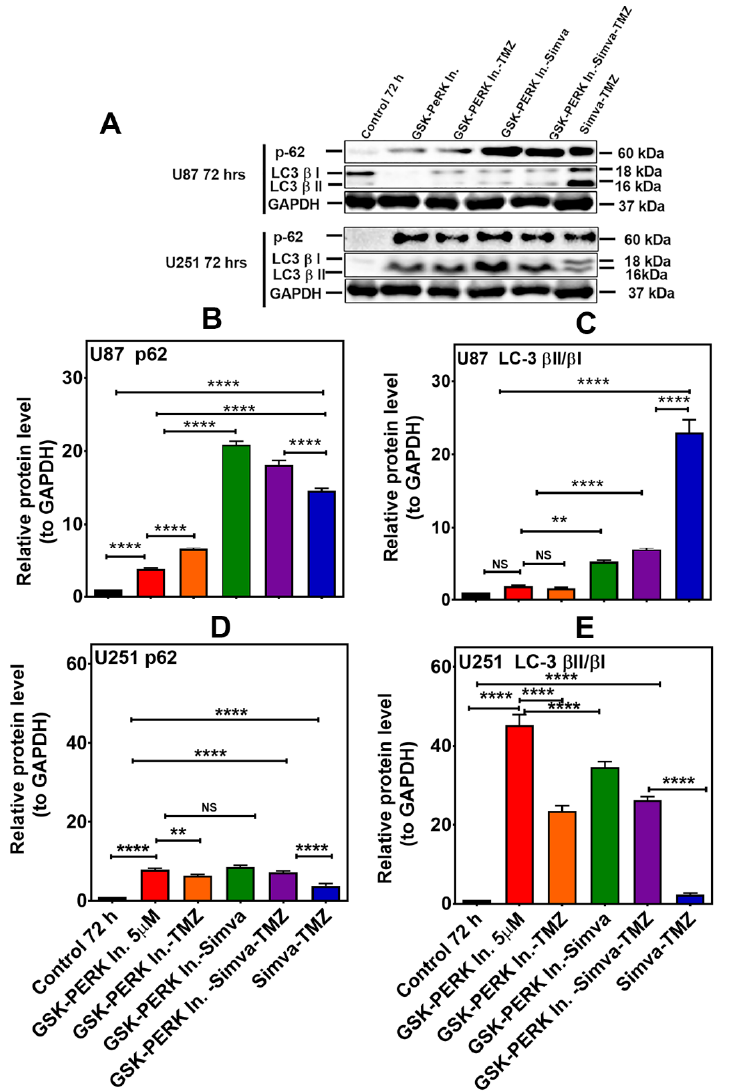
Figure 7. PERK inhibition di ff erentially a ff ects autophagy flux in U87 and U251 cells treated